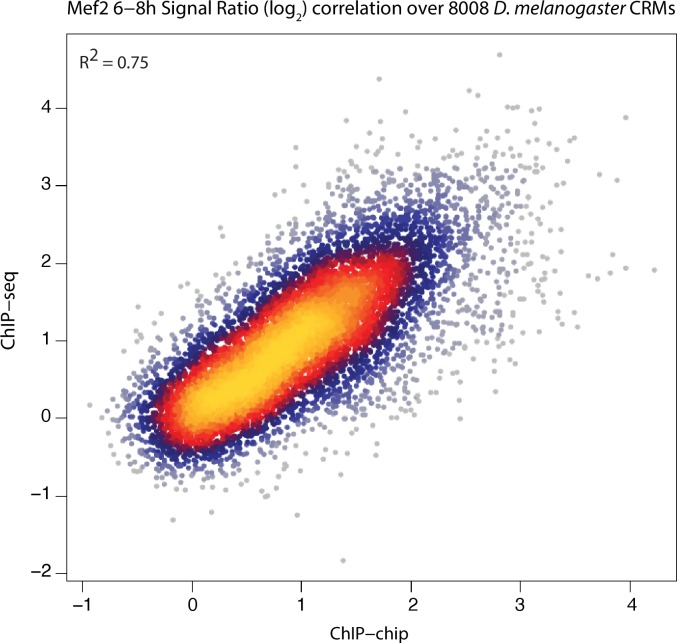
ChIP-chip and ChIP-seq signals are highly correlated.ChIP-chip and ChIP-seq signal for Mef2 over all D. melanogaster CRMs are plotted here. ChIP-chip signals correspond to mean ChIP-chip intensity signals calculated over 200 bp sliding window with 35 bp steps along the CRM length. ChIP-seq signals correspond to Log2(IP/input). Mef2 ChIP-seq signals over D. melanogaster 8,008 CRMs were generated previously (Bonn et al., 2012). Pearson correlation coefficient between both sets is shown.